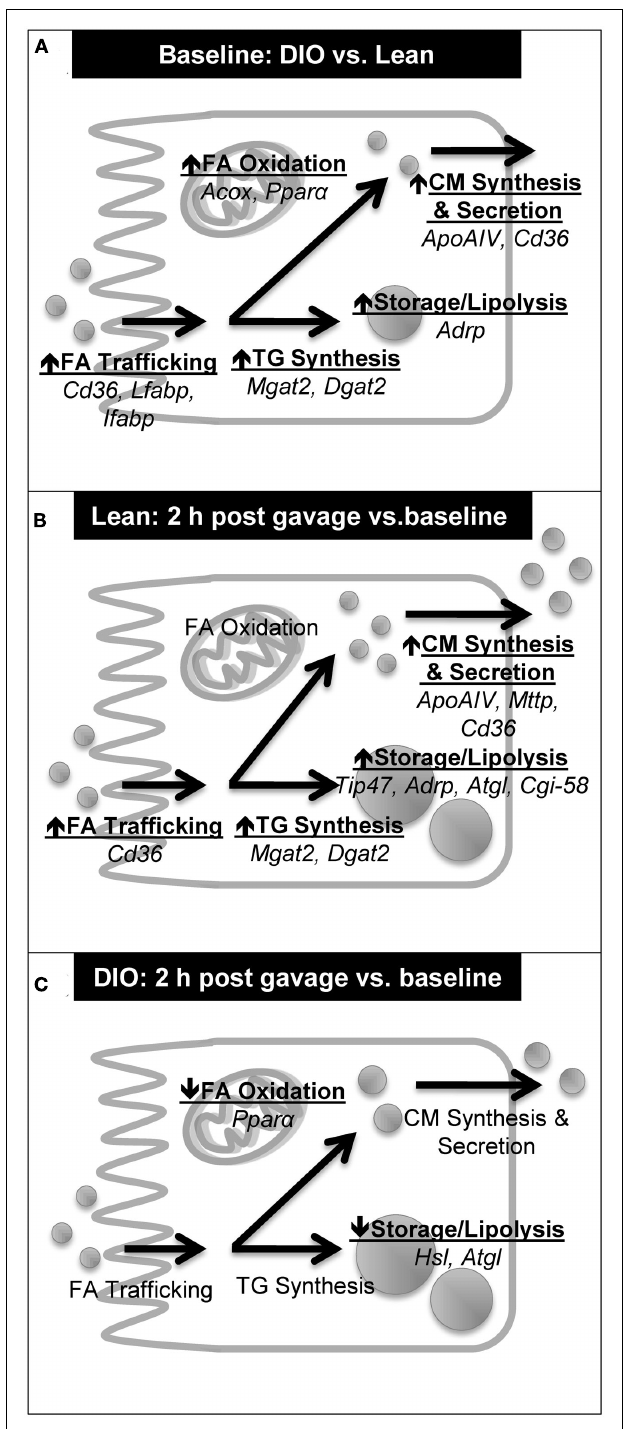
FIGURE 5 | Summary of induction patterns of mRNA levels for genes involved in intestinalTG metabolism. (A) Summary of mRNA levels in jejunum of DIO compared to lean mice at baseline (6h fast). (B) Summary of mRNA levels in jejunum of lean mice at 2h post oil bolus compared to baseline (6h fast). (C) Summary of mRNA levels in jejunum of DIO mice at 2h post oil bolus compared to baseline (6h